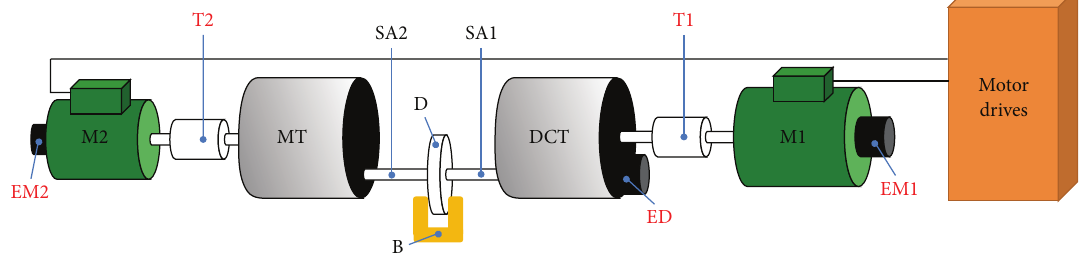
Figure 2: Layout of the transmission test bench: electric motors (M1, M2), speed sensors (encoders EM1, EM2, and ED), torque sensors ( T 1, T 2) , disk (D), brake (B), and output half shafts (SA1, SA2).